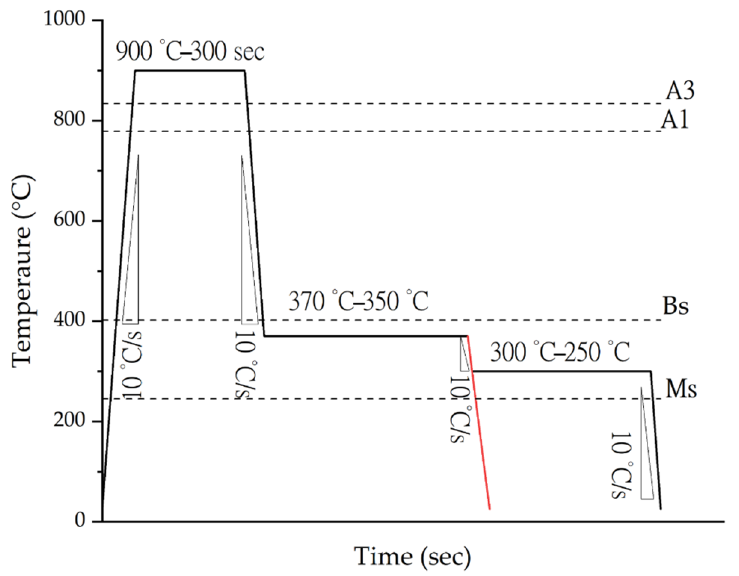
Table 1. Chemical composition (wt.%) of the Investigated alloy.